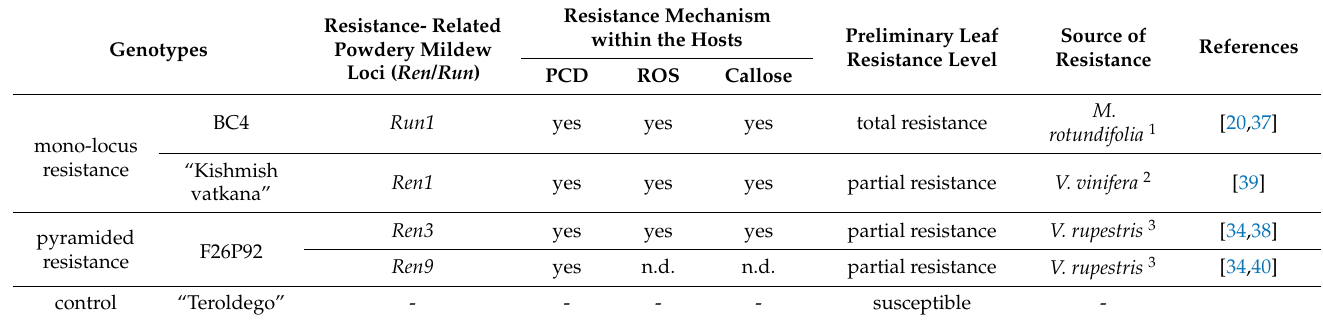
Table 1. The grapevine varieties used in this study together with their origin ( 1 North American Vitis ; 2 pure V. vinifera , 3 interspecific hybrids of V. vinifera with North American Vitis species), host response (PCD (programmed cell death), ROSs (reactive oxygen species), n.d. (not determined)), and their powdery-mildew-associated resistance-related loci ( Ren / Run ). The levels of resistance described in the table: total = greatly suppressed symptoms or the absence of visible symptoms; partial = in cases where the symptomatology decreases without disappearing completely [35,36].